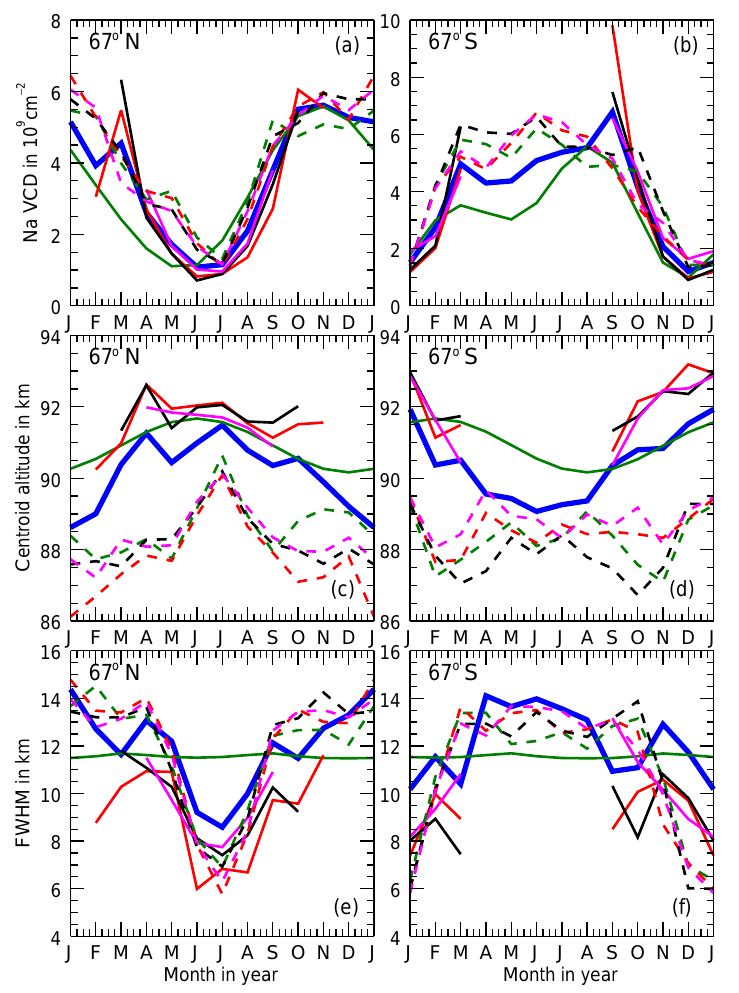
Figure 10. Vertical column density (a–b) , centroid altitude (c–d) and FWHM (e–f) of the discussed datasets for 67 ◦ N (a, c, e) and 67 ◦ N (b, d, f) . The different colors are the ensemble mean (blue), GOMOS (green, solid), OSIRIS descending leg (red, solid), OSIRIS ascending leg (black, solid) and SCIAMACHY (magenta, solid). WACCM colocated with the instruments’ LT is dashed in the same color as the